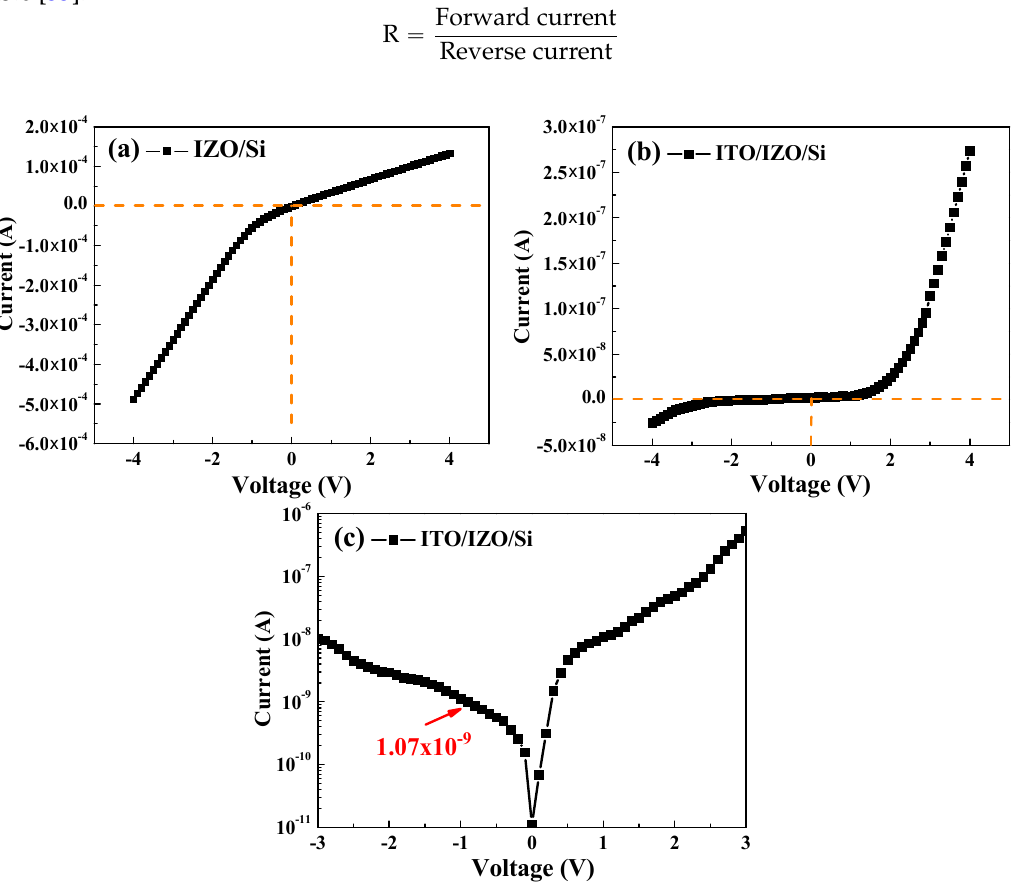
Figure 8. I − V characterization curves of the ( a ) IZO/Si and ( b ) ITO/IZO/Si heterojunction diodes; ( c ) the log(|I|) − V curve of the ITO/IZO/Si heterojunction diode.